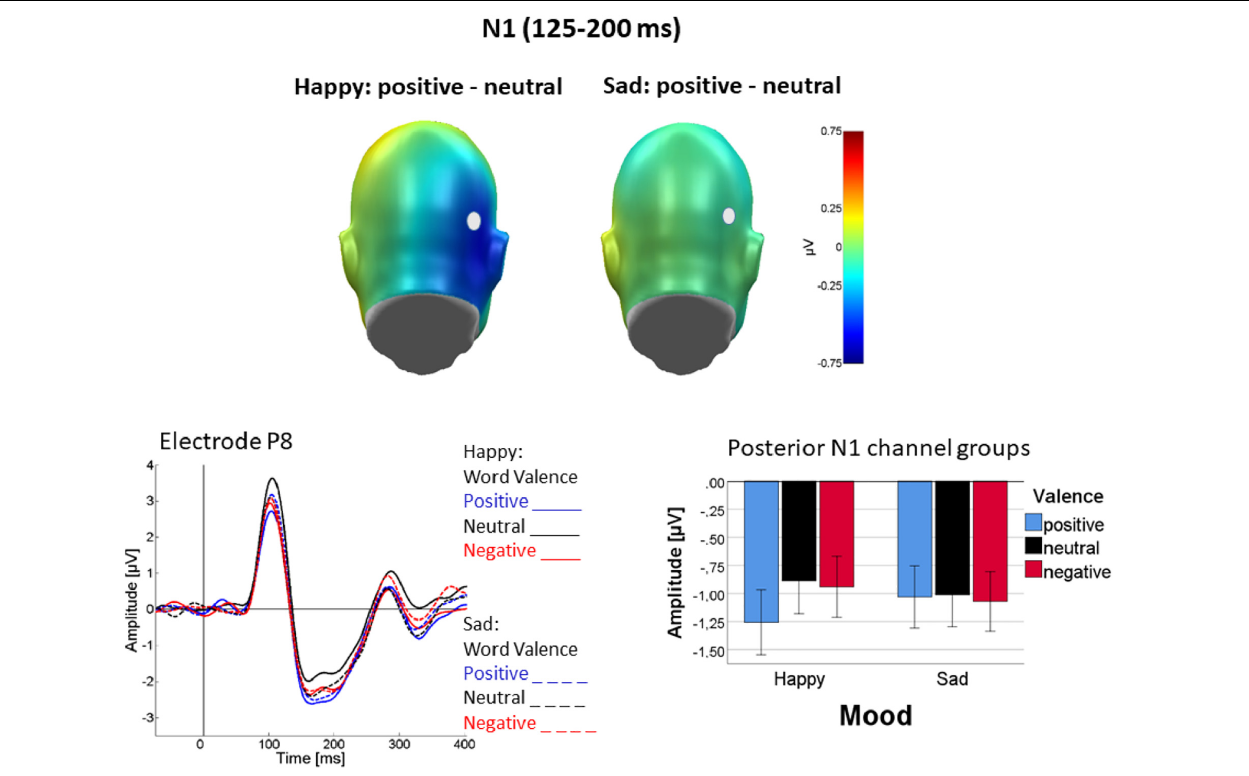
FIGURE 3 | Difference topographies illustrating mean N1 activation (125–200 ms) during processing of emotional (positive and negative) minus neutral adjectives in happy (top left) and sad (top right) mood. Representative sensor P8 illustrates the ERP time course for the different conditions (solid: happy mood; dashed: sad mood; word valence: blue—positive, black—neutral, red—negative. Bar plots show posterior N1 activity averaged across both occipital sensor groups and the entire N1 interval (125–200 ms). Error bars are standard